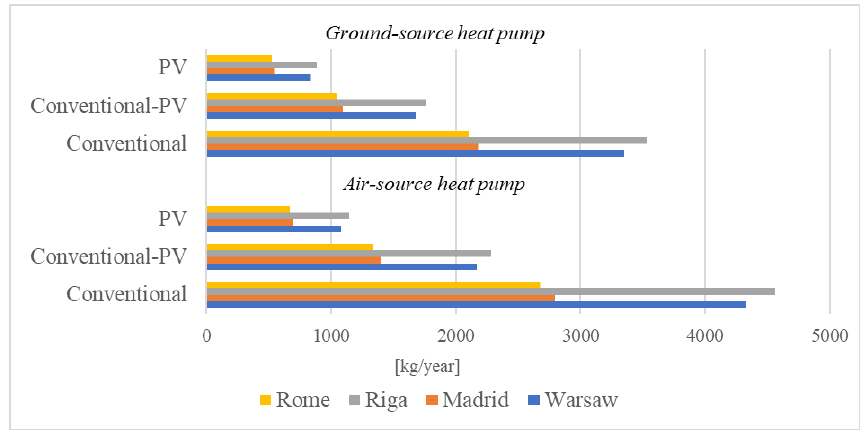
Figure 6. Estimation of total CO 2 emissions. Estimated CO 2 emissions for a typical year, taking into account energy production for each source of energy and location, are considered in the paper. It can be seen that for